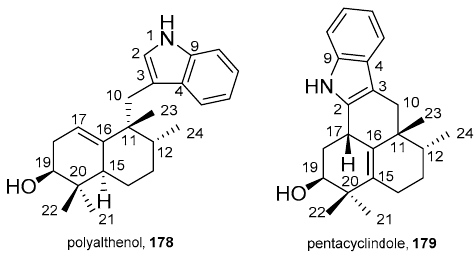
Figure 11. Polyalthenol and pentacyclindole structures.